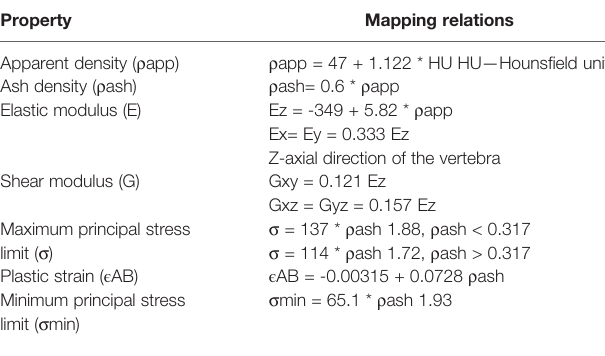
TABLE 1 | Vertebral bone material mapping relations used in the current fi nite element study (22).